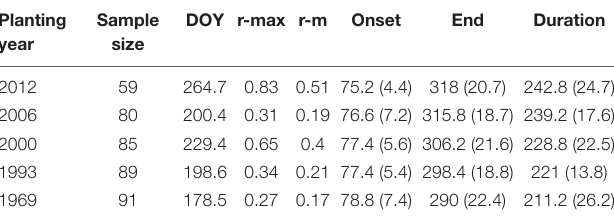
TABLE 4 | Characteristics of the rate of wood cell